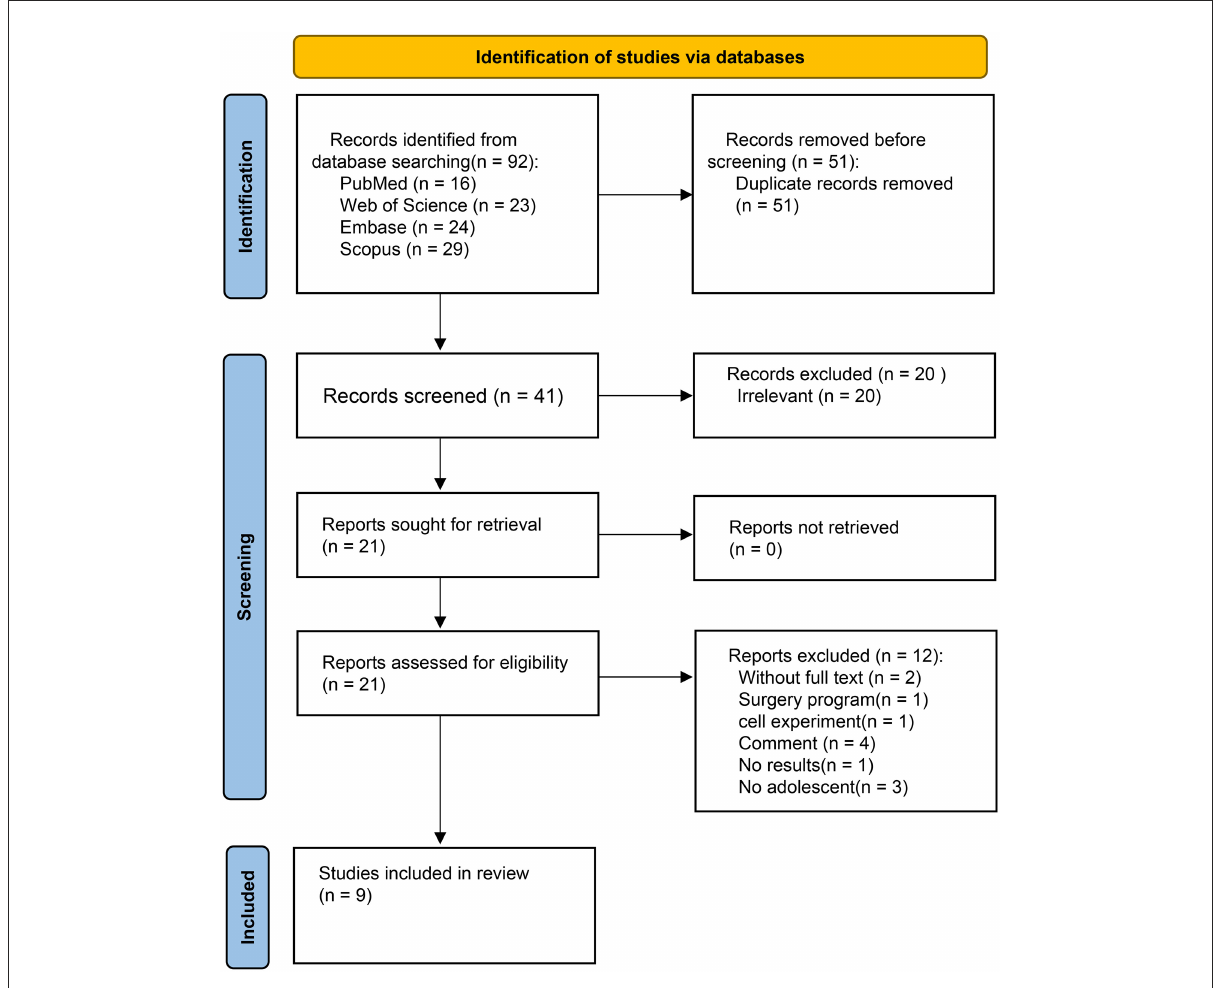
FIGURE1 Flow chart showing the process of literature